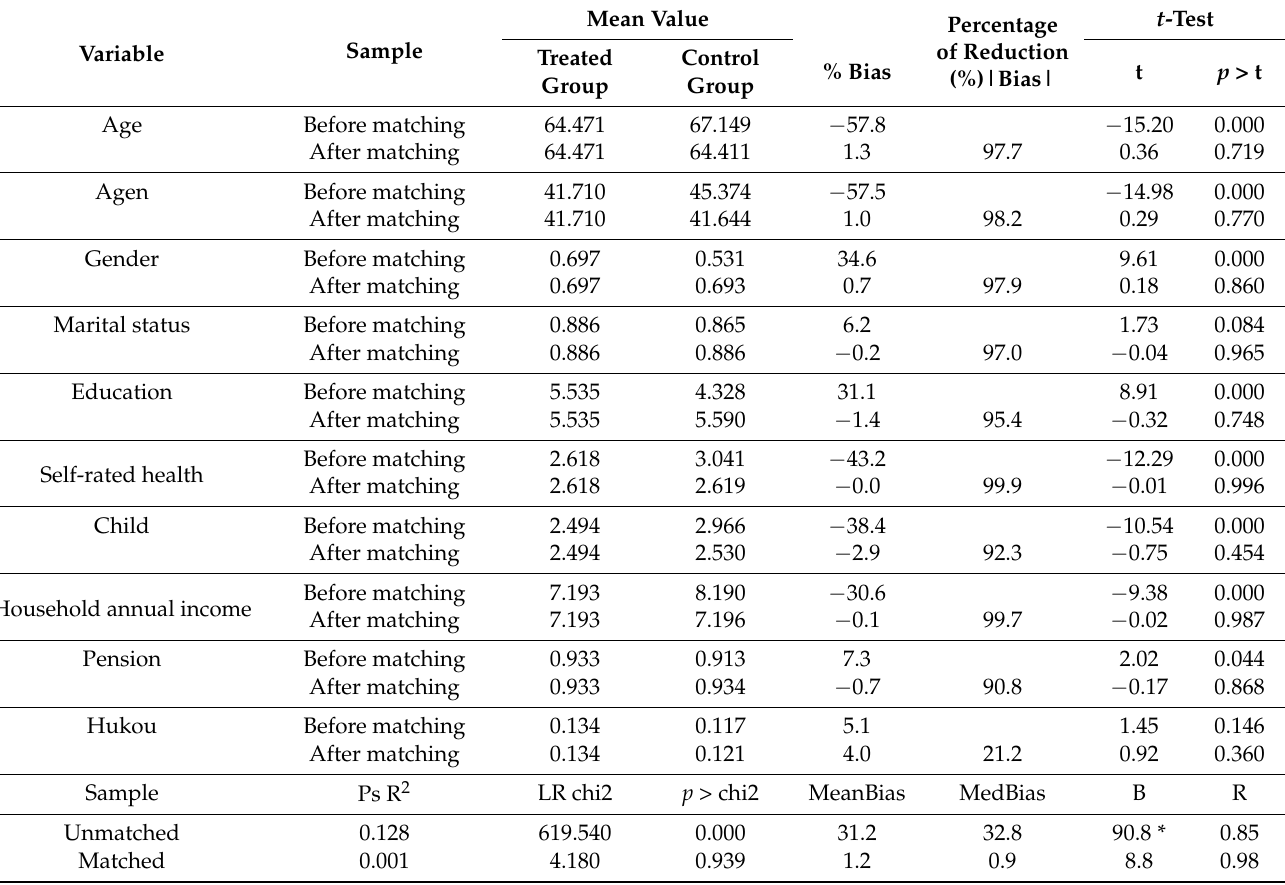
Table 4. Results of PSM data-balanced test.